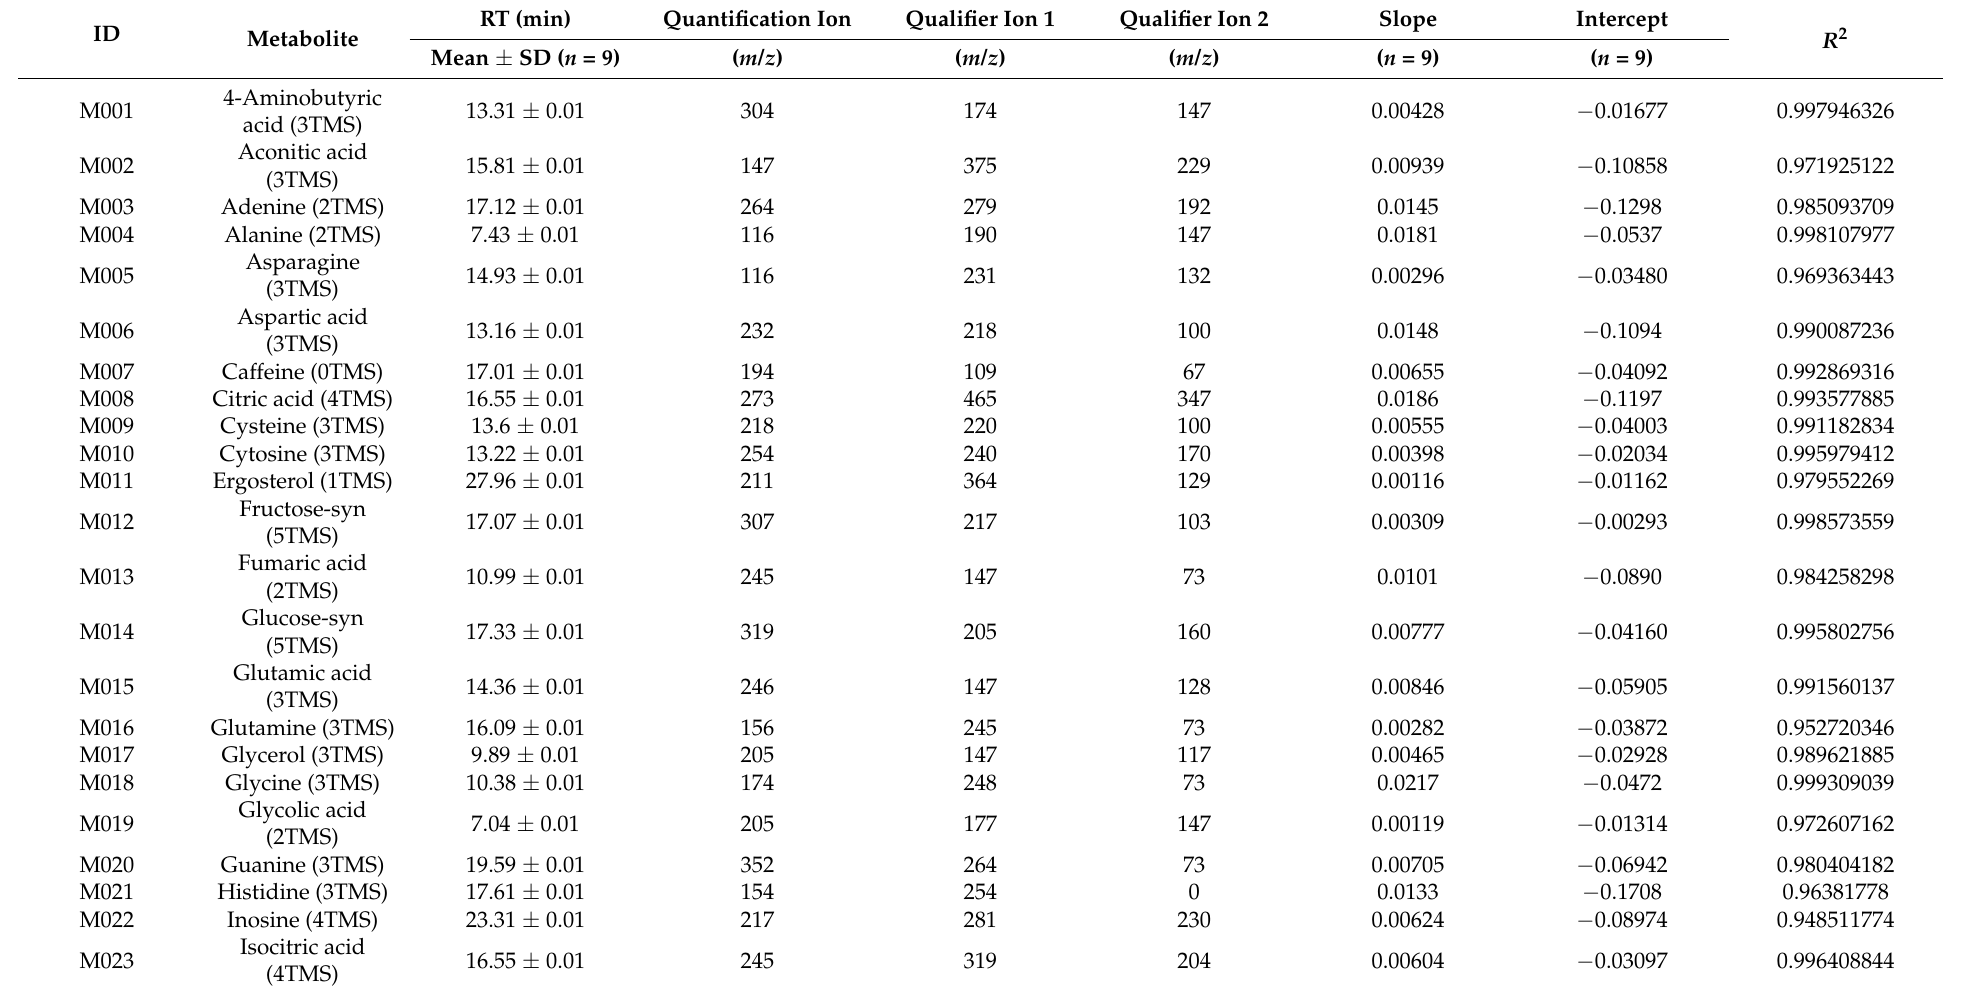
Table 1. Data collection for CCLD